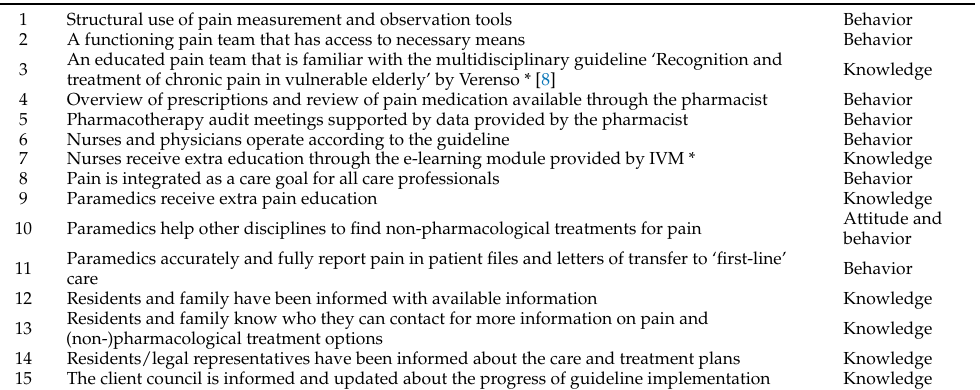
Table 2. Summary of implementation